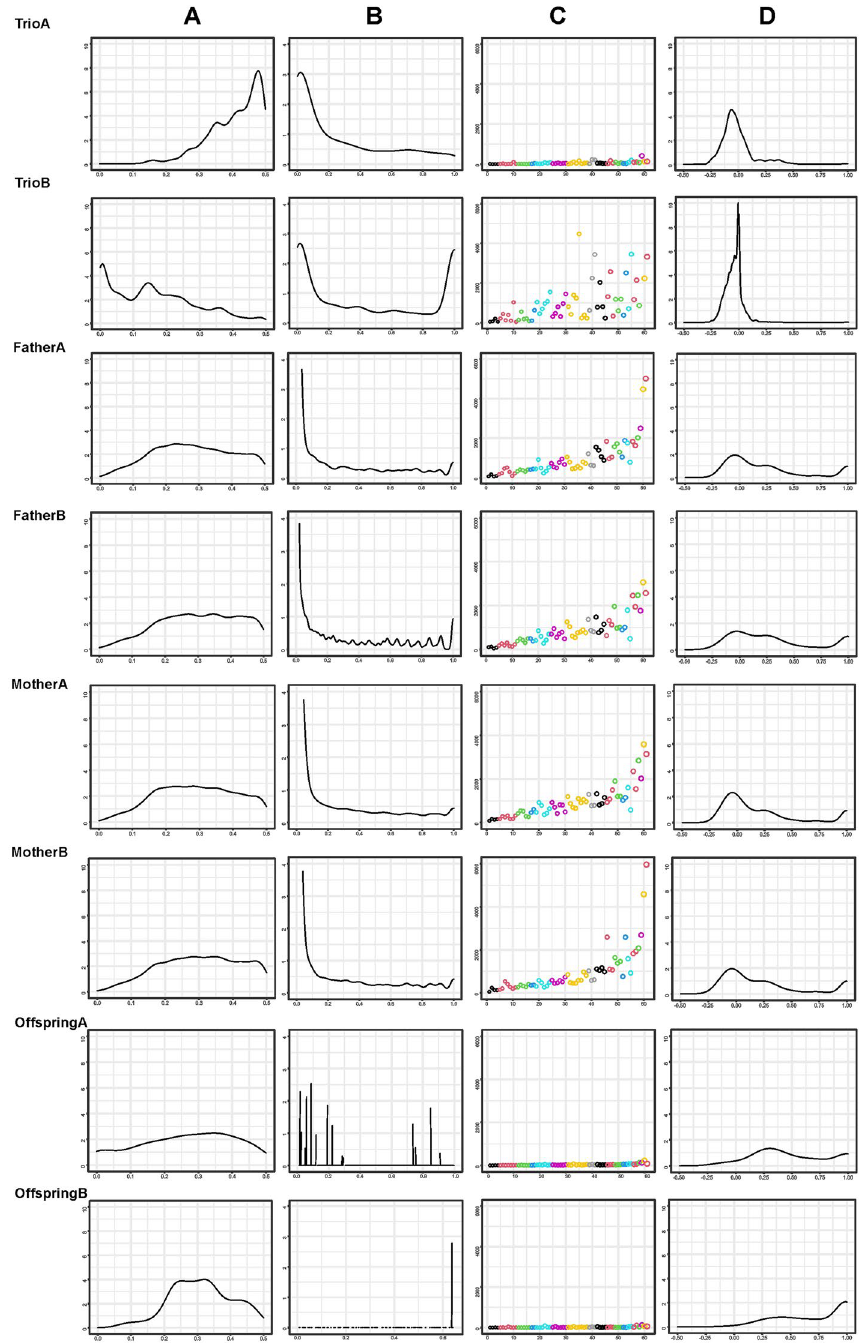
Figure 5. Plots characterizing the SNPs included in the ME set according to the eight classes of ME defined (TrioA; TrioB; MotherA; MotherB; FatherA; FatherB; OffspringA; and OffspringB). Density plots of the minor allele frequency (MAF) are shown in column ( A ); density plots of the probability ( p ) of the deviation of the Hardy–Weinberg proportions (HW) are shown in column ( B ); dispersion plots constructed according to the family size (on the X-axis) and the number of ME identified per family (on the Y-axis) are illustrated in column ( C ); finally, density plots of the F IS variation are shown in column ( D